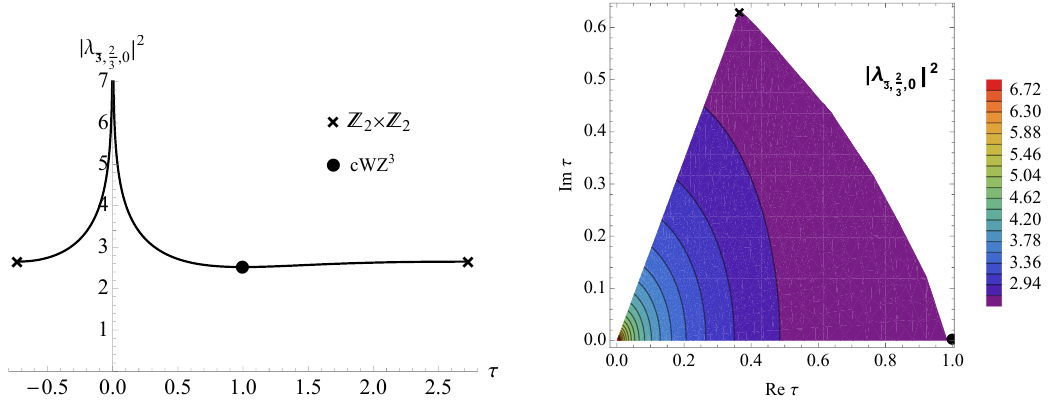
(cid:0)p p (D.5) for real 1 3 (cid:20) (cid:28) (cid:20) 1+ 3 (cid:22) 3 ; 2 ; 0 3 (cid:6)p 3 ; 1 for the Z 2 (cid:2) Z 2 and cWZ 3 models,